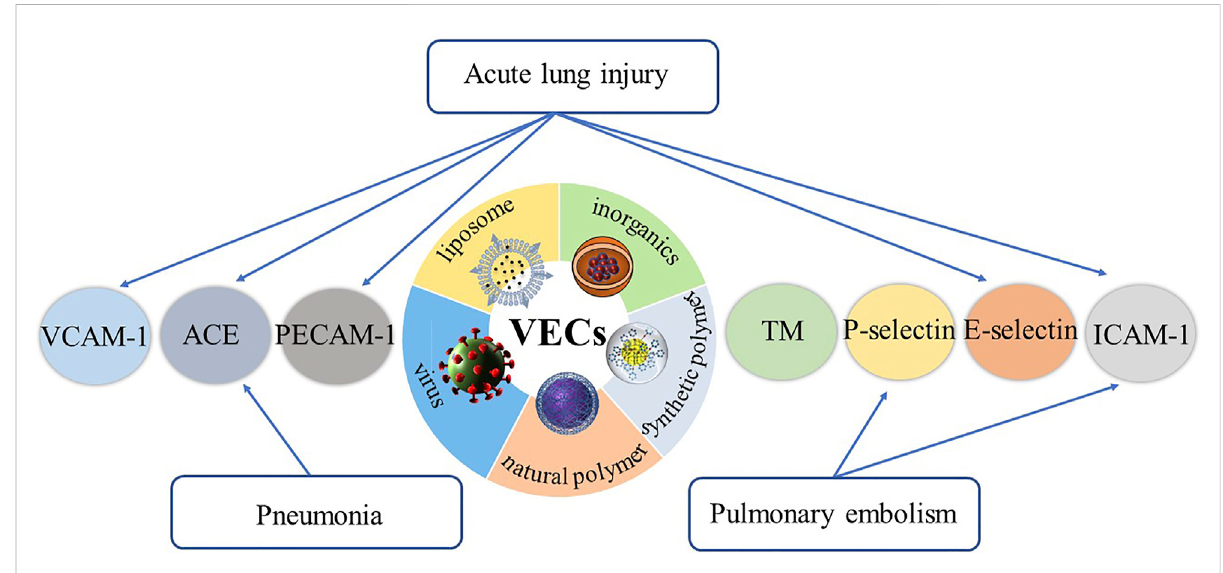
FIGURE 1 Therepresentativespeci fi creceptorsexpressedonVECsattheonsetofrespiratorydiseases,anddrugdeliverysystemsdesignedtotargetthese